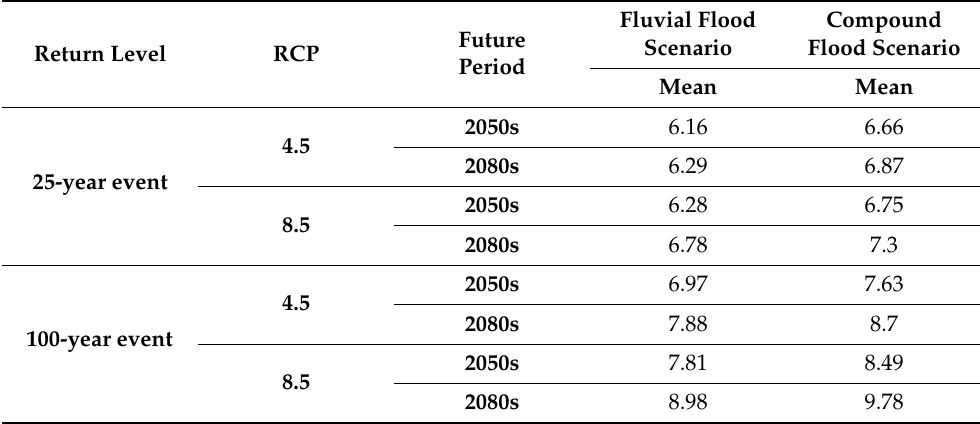
Table 4. Projected flood inundation extents (square meter) based on WRF-IDF curves (multi-model means of six GCMs).